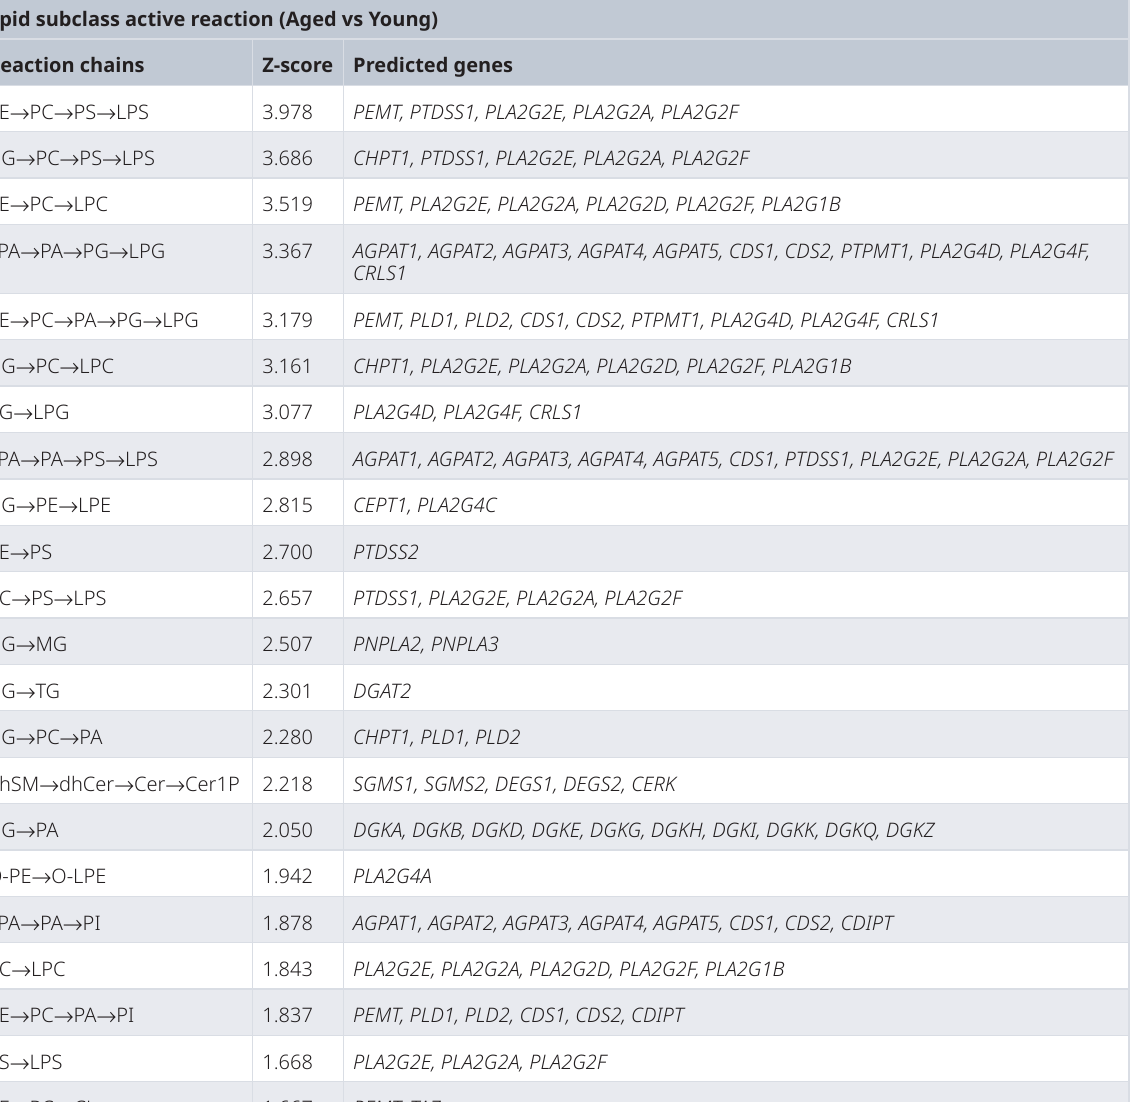
Table 1. BioPAN predicted genes of the lipid active reactions in liver of aged vs young mice. Table contains the active reactions chains found by BioPAN according to the Z-score values. Several genes are predicted as being involved in the current status of each reaction based on their function. Pathway options: aged condition of interest, young control condition, lipid type, active status, subclass level, reaction subset of lipid data, p value 0.05, no